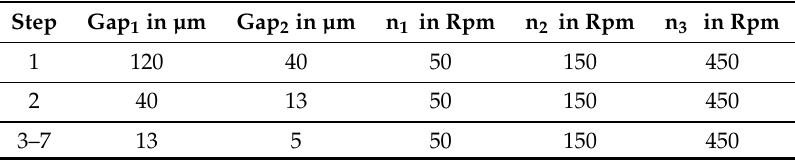
Table 3. Process parameters for dispersion on three-roll mill 80E